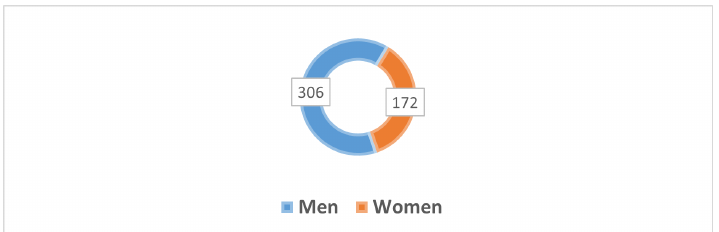
Figure 1. Distribution of victims by gender